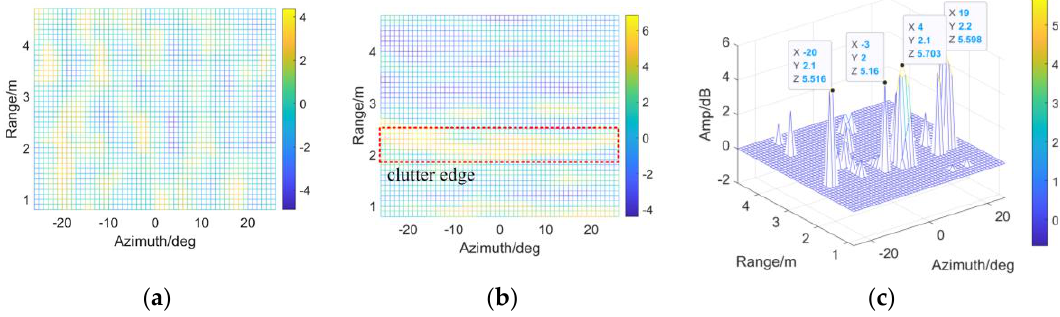
Figure 13. Detectability are improved according to the VIs: ( a ) VI in azimuth; ( b ) VI in range; ( c ) 𝜂 of